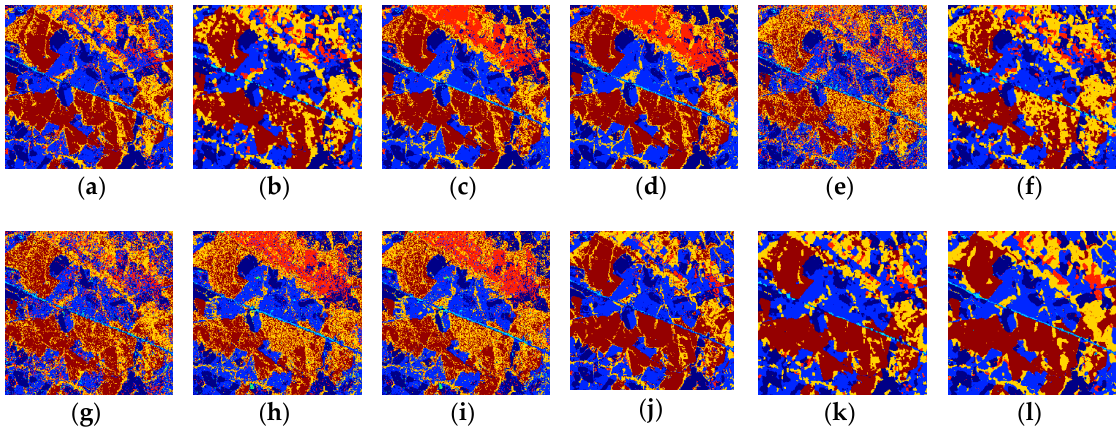
Figure 5. Classification results on the CBERS-2B image obtained by using the ( a ) k-NN, ( b ) k-NN-WH-MV, ( c ) k-NN-SRM, ( d ) k-NN-SRM-IC, ( e ) OPF, ( f ) OPF-WH-MV, ( g ) OPF-MRF, ( h )